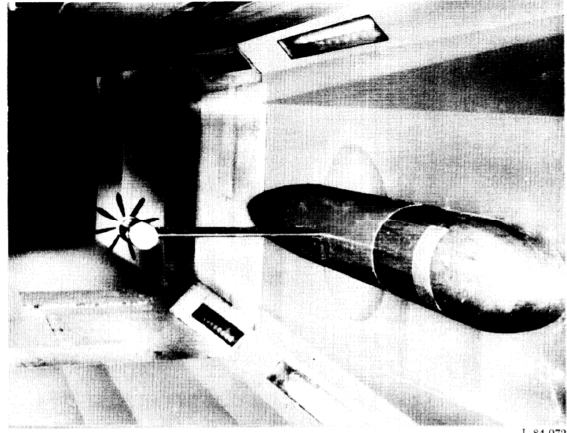
Figure 20. Wing-tip mounted pusher turboprop model in Langley 7- by 10-Foot Speed Tunnel. Reproduced from Ref. [73]. Reproduced from Ref.